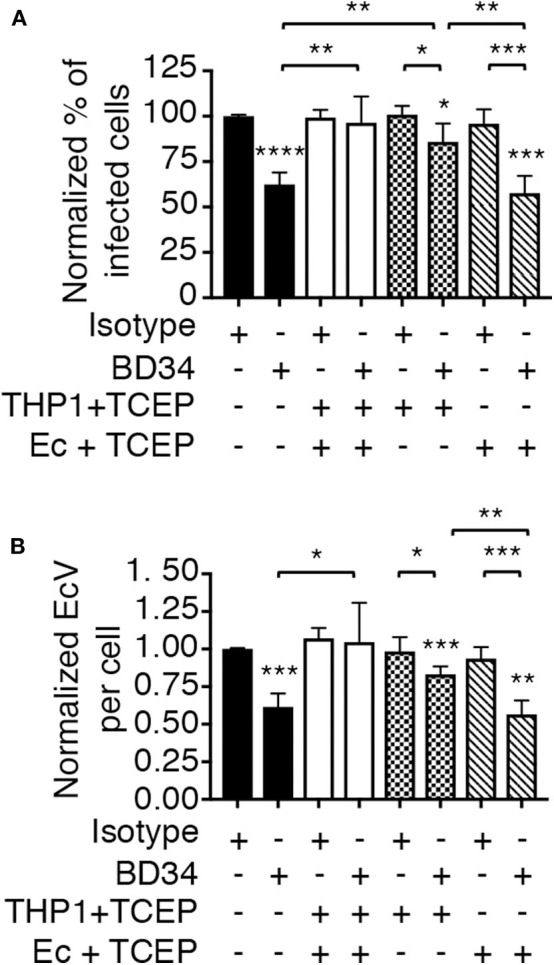
PDI-mediated thiol reduction at the host cell surface contributes to E. chaffeensis infection. THP-1 cells were treated with antibody BD34 to inhibit cell surface PDI activity or with isotype control antibody. The THP-1 cells were then incubated in culture medium containing TCEP for 30 min to reduce host cell surface disulfide bonds or culture medium alone followed by incubation with E. chaffeensis DC bacteria. Alternatively, DC organisms were treated with TCEP for 30 min to reduce ehrlichial surface disulfide bonds followed by PBS washing and then incubation with BD34- or isotype control-treated THP-1 cells. At 24 h, the host cells were examined using immunofluorescence microscopy to determine the percentage of infected cells (A) and number of EcVs per cell (B). Data are the mean ± SD of triplicate samples and are representative of four separate experiments. Statistically significant values are indicated. *P < 0.05; **P < 0.01; ***P < 0.001; ****P < 0.0001. Asterisks above columns indicate statistically significant differences in infection relative to isotype control-treated cells, while asterisks over brackets denote statistically significant difference between the indicated pairs.